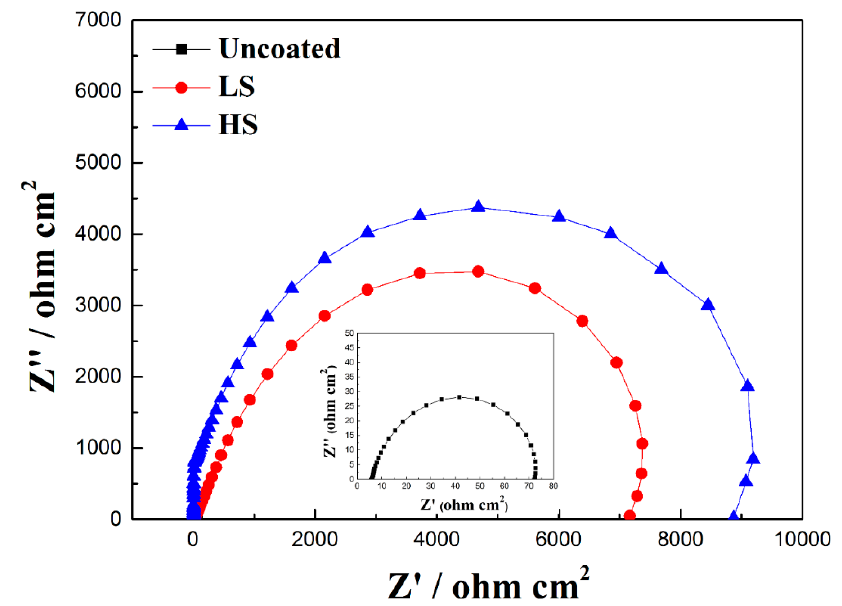
Figure 7. The Nyquist plots of the uncoated, LS and HS samples in the 0.5 M HCl solution at 30 °C (inset is a magnified Nyquist plot of the uncoated sample).